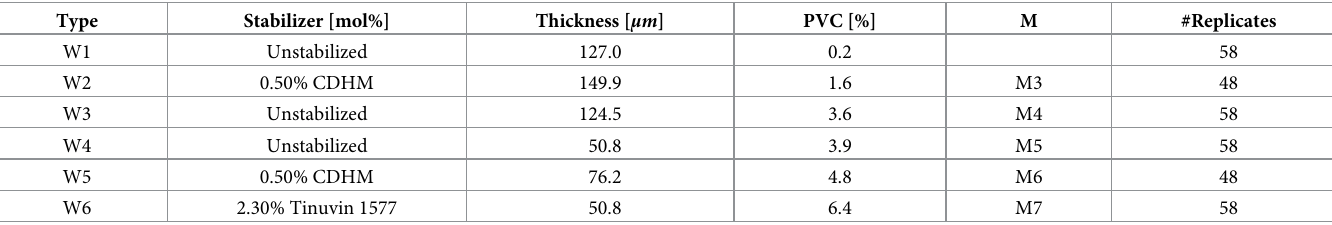
Table 2. Properties of white grades of PET film. “Unstabilized” indicates that the samples are free of chemical stabilizers. PVC is the pigment volume concentration of TiO 2 . “M” represents the material grade indicator variable encoding that will be used for modeling of white films. “#Replicates” represents the number of individual repli- cates for each grade in the study.